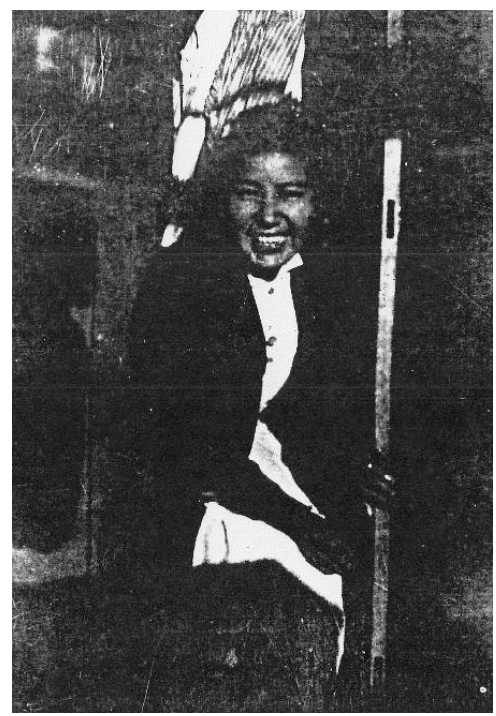
Figure 20. Nettie Odlety, ca. 1916. Parker McKenzie Collection. Courtesy of the Oklahoma Historical